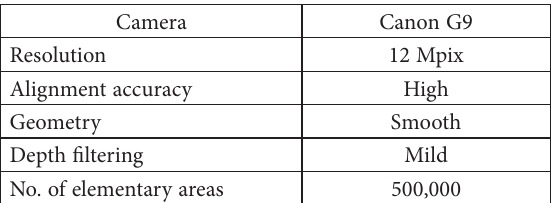
Table 2. 3D model test parameters